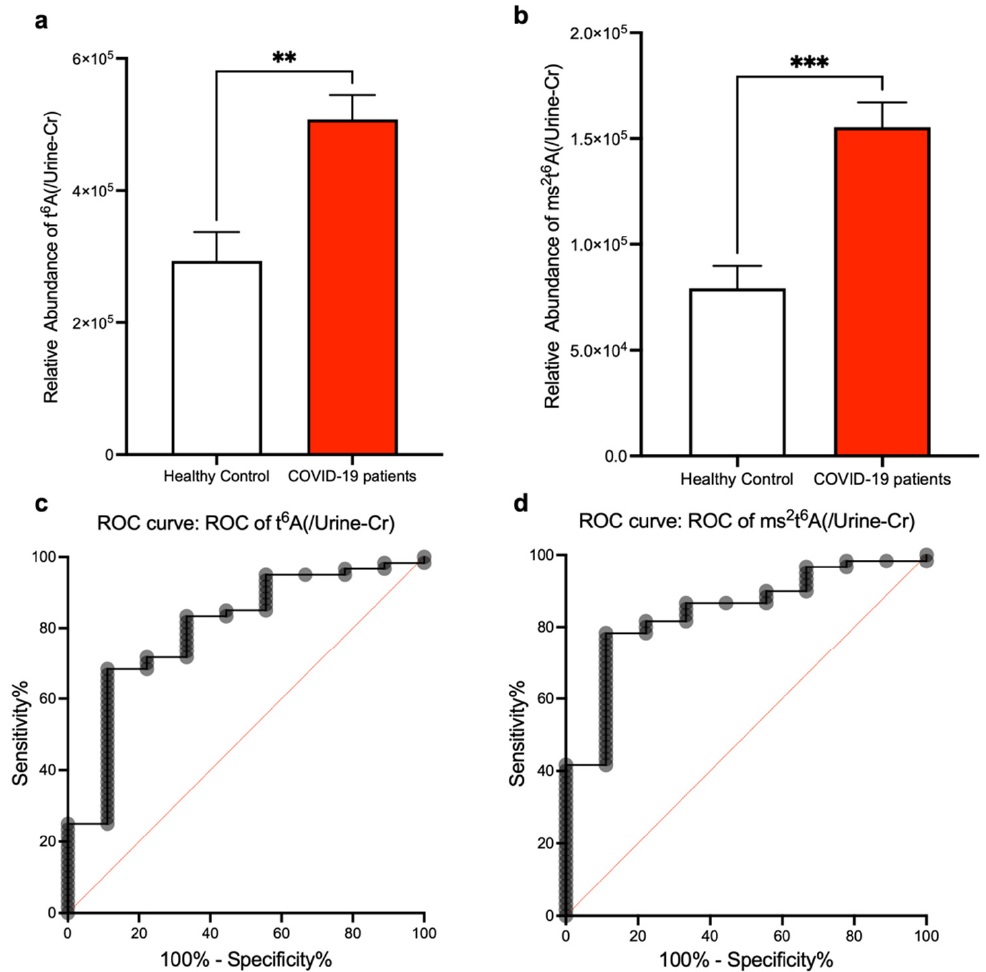
Figure 2 . SARS-CoV-2 infection causes elevation of t 6 A and ms 2 t 6 A levels in urine. ( a , b ) Measure- ments of t 6 A ( a ) and ms 2 t 6 A ( b ) in urine and comparison with healthy volunteers. LC-MS peak areas of t 6 A and ms 2 t 6 A divided by urine creatinine levels are shown. ** p < 0.01, *** p < 0.001 by Mann– Whitney U test. ( c , d ) ROC analysis for measurements of t 6 A ( c ) and ms 2 t 6 A ( d ) in urine was per- formed for calculation of sensitivity and specificity.